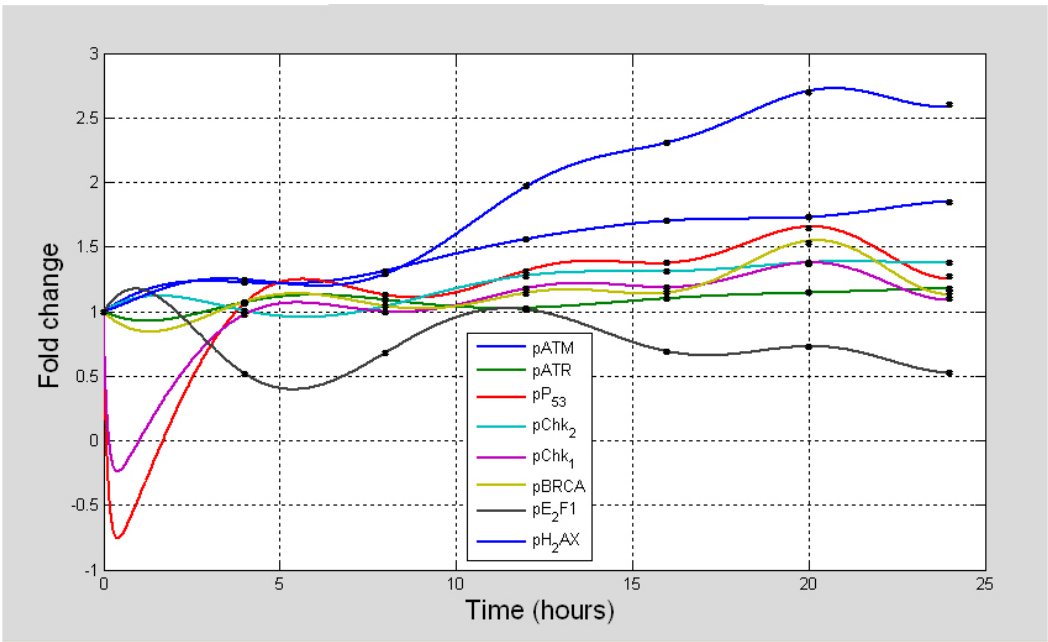
Figure 13. Simulated system dynamics of the DDR pathway that are most consistent with the historical time series measure- ments at (0.1 µ M) dose-intensities of doxorubicin without KU